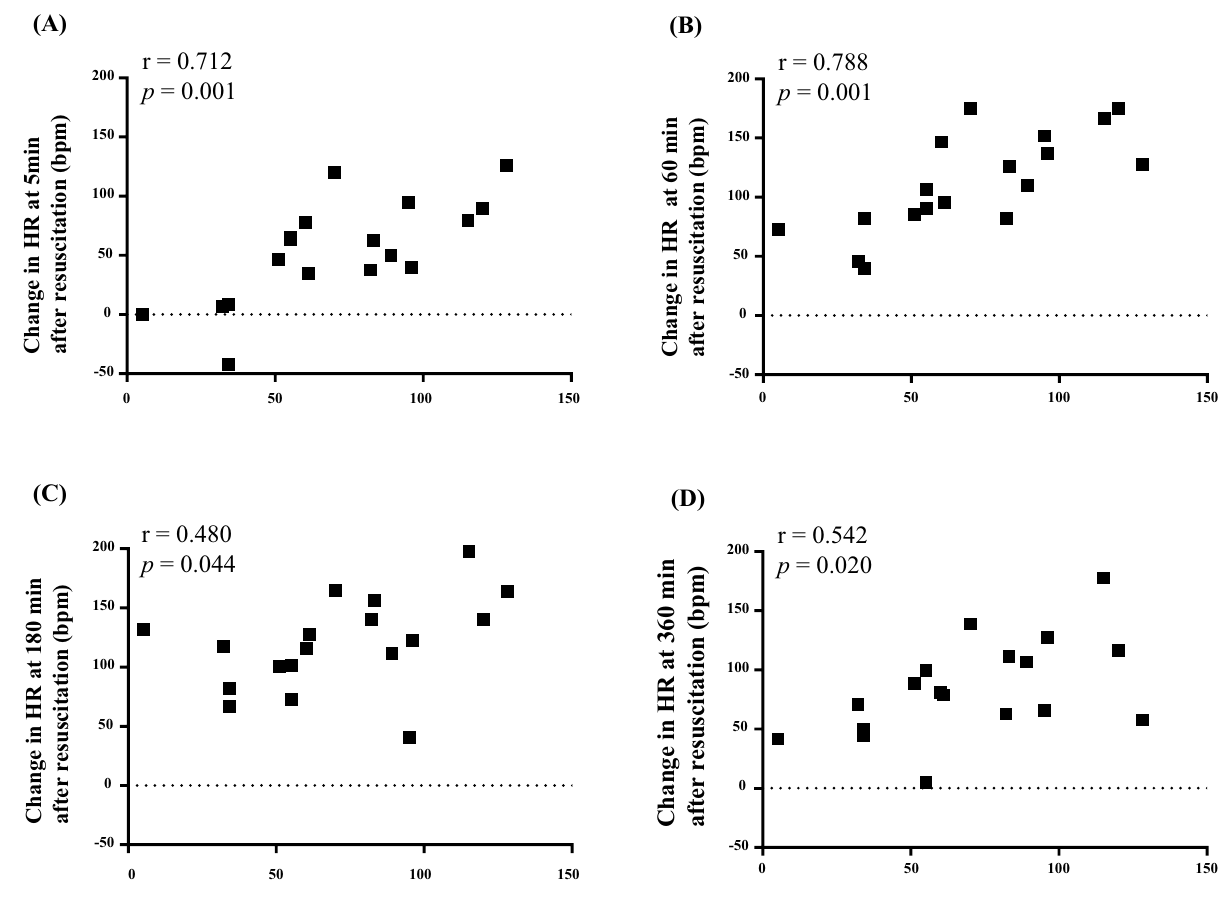
Figure 3. Correlation between change in HR during insult and change in HR at ( A ) 5 min, ( B ) 60 min, ( C ) 180 min, and ( D ) 360 min after insult. HR changes were defined as the differences between the HR value at peak CBV during insult and the HR value immediately before resuscitation 5, 60, 180, and 360 min after insult.